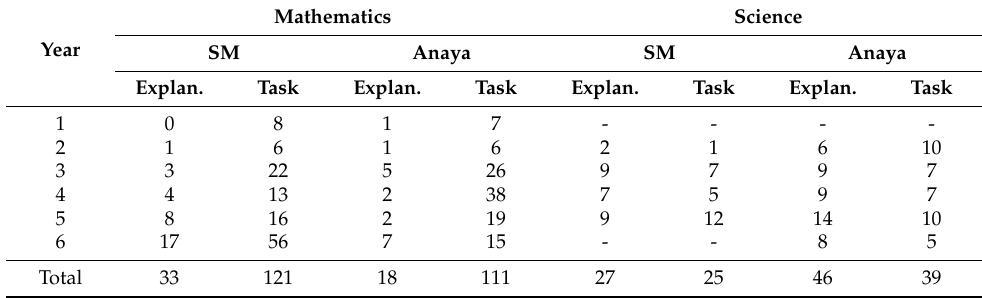
Table 1. Units of analysis in